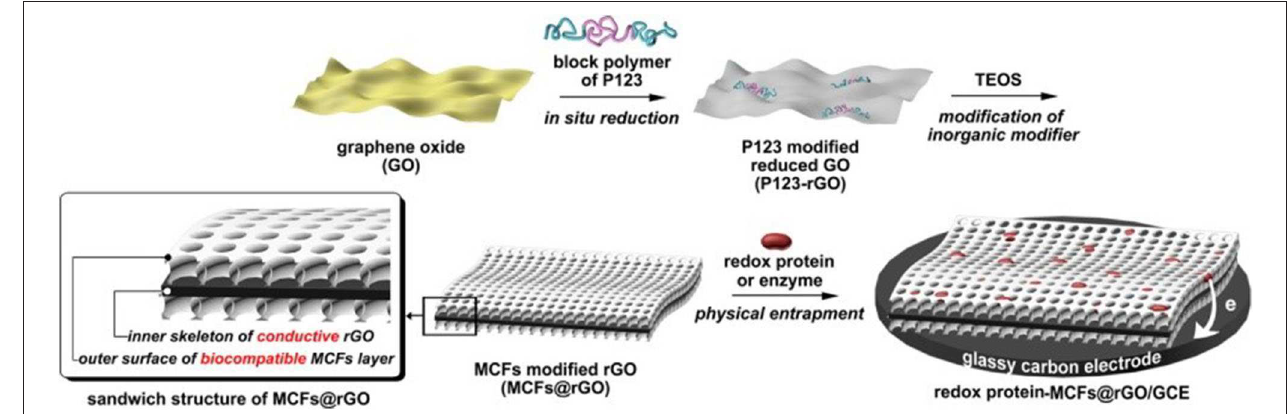
FIGURE 2 | Fabrication of the MCF@rGO composite for the achievement of